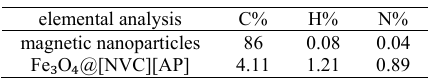
Fig.1. SEM image of Fe